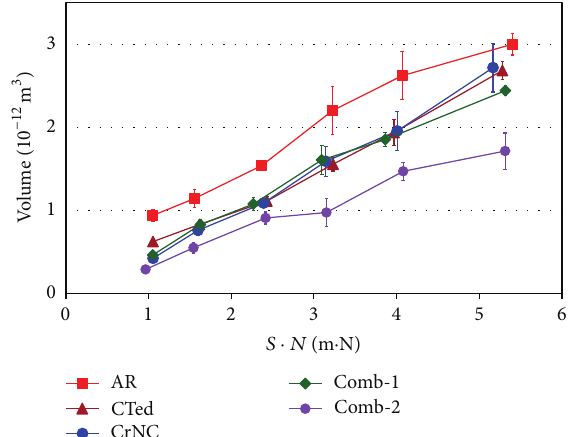
Figure 5: Wear volume versus sliding distance multiplied by the contact force.